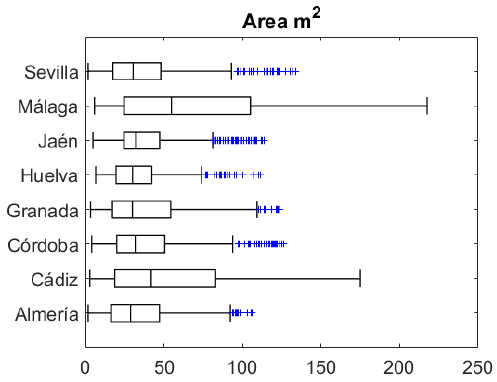
Figure 11. Estimation of the crown area by province.